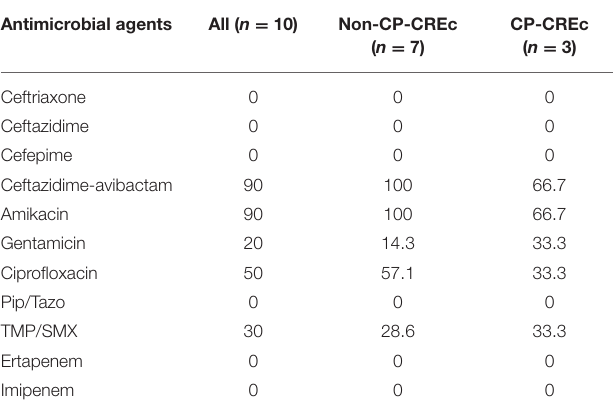
TABLE 3 | The susceptibility patterns to different antimicrobial agents between non-carbapenemase-producing and carbapenemase-producing carbapenem-resistant E. coli